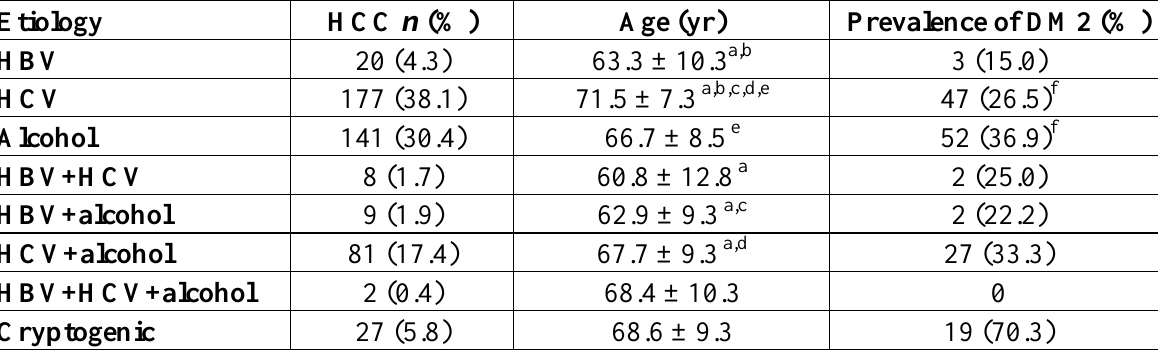
Table 3. Etiology, mean age and prevalence of type 2 diabetes mellitus in 465 HCC patients. (mean ±